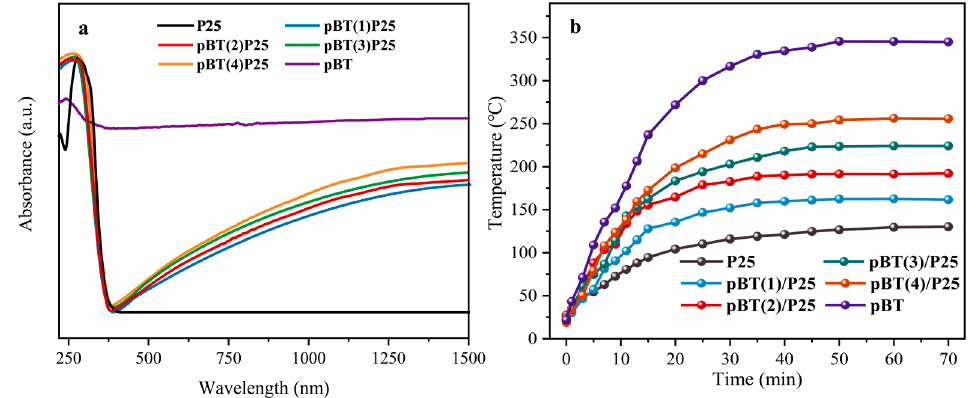
Figure 2. ( a ) UV–vis–NIR spectra of pBT, pBT(x)/P25 (x = 1, 2, 3, 4), and P25; ( b ) In situ monitoring of the photothermal temperatures over P25, pBT(x)/P25, and